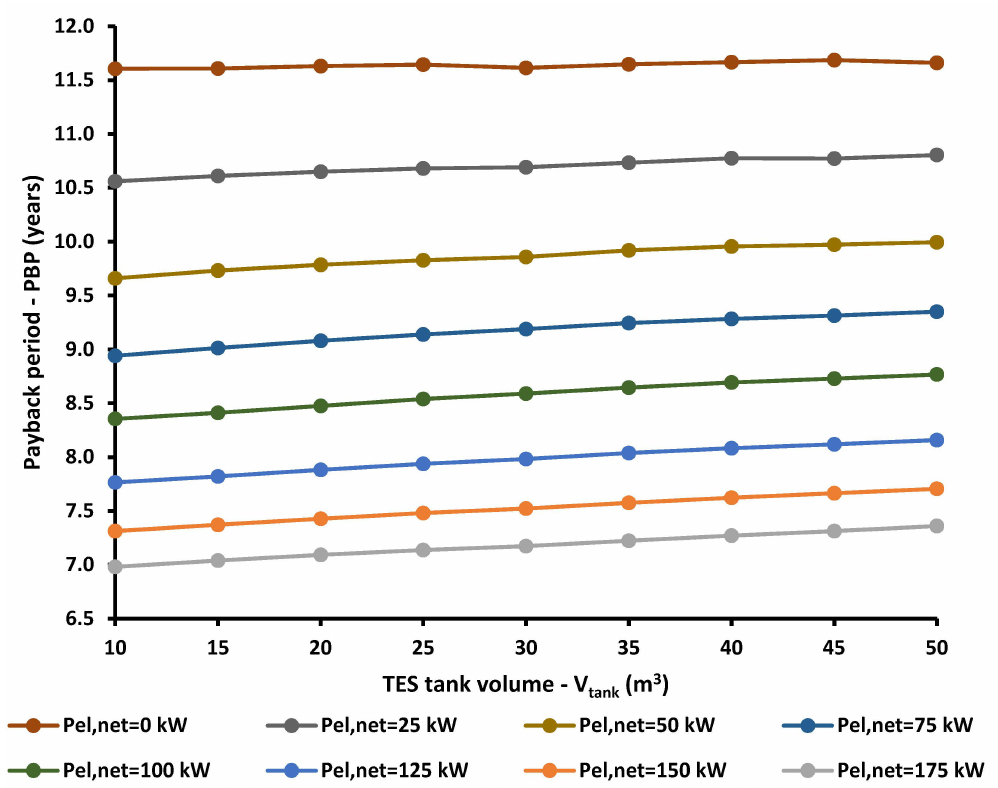
Figure 10. Payback period for different values of net electricity load and TES tank volume when the hydrogen price is equal to 15